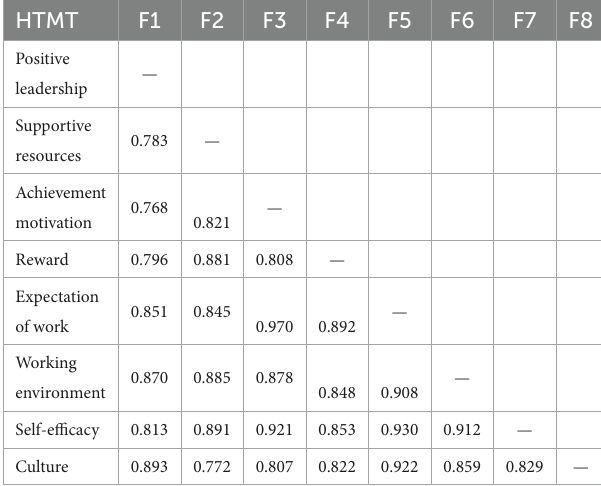
TABLE 2 Heterotrait – Monotrait (HTMT) of the questionnaire ( N = 473). HTMT